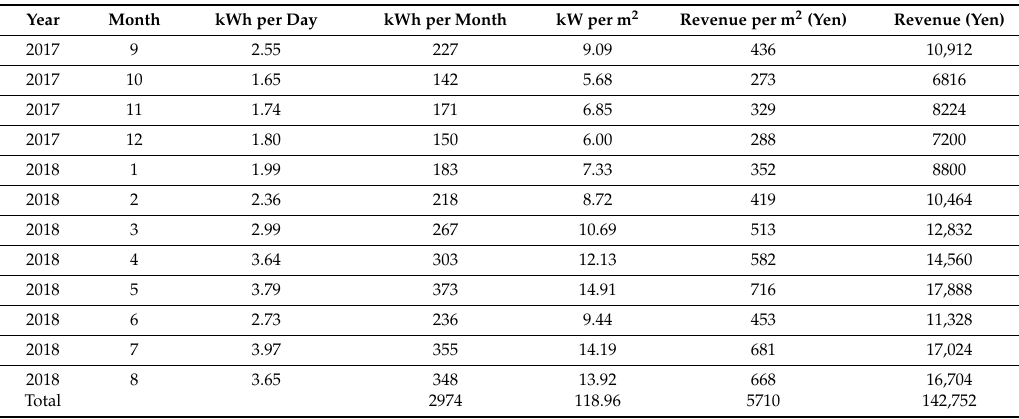
Table 4. Power output (kWh) of stilt-mounted agrivoltaic PV modules in the high-density